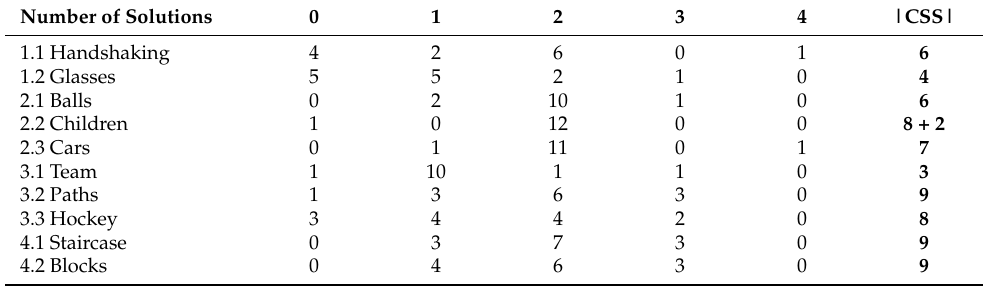
Table 4. Size of